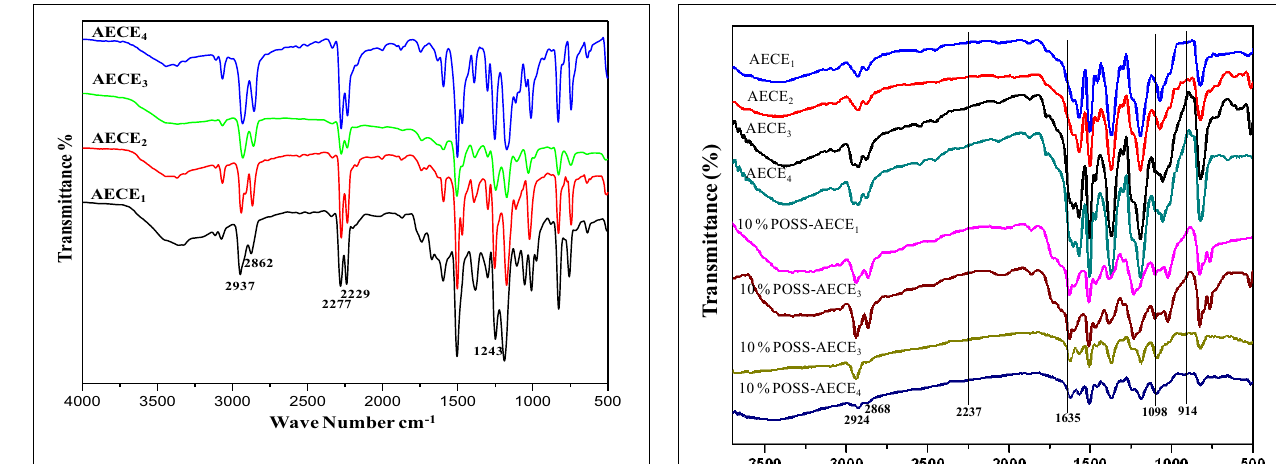
Figure 1 | FT-IR spectra of linear aliphatic alkoxy core bridged cyanate esters.